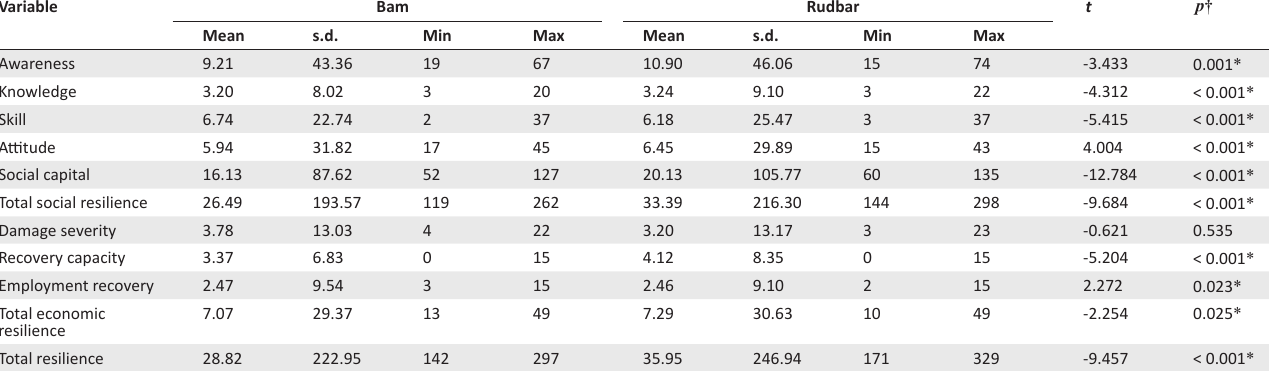
TABLE 5: Summary statistics of the components used in measurement of economic and social resilience of the participants.